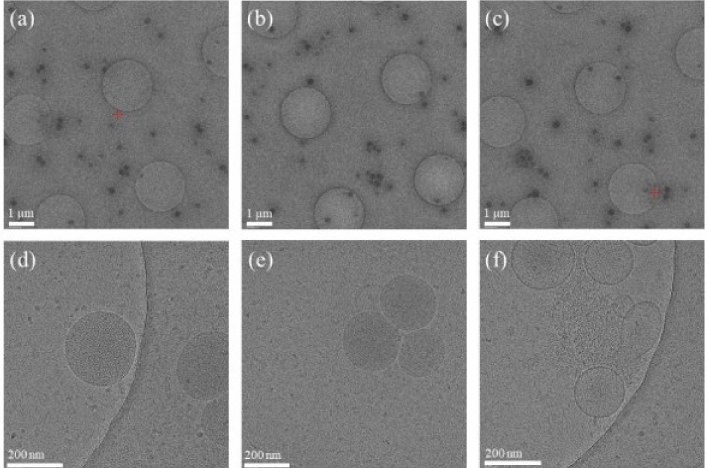
Figure A2. Cryo-TEM images of hbEVs isolate at low ( a – c ) and high ( d – f ) magnification taken 6 weeks after isolation. When considering the shape and size of hbEVs, the ice thickness should be between 80 and 150 nm, and the visible contours do not necessarily represent the three-dimensional shape of the hbEVs.